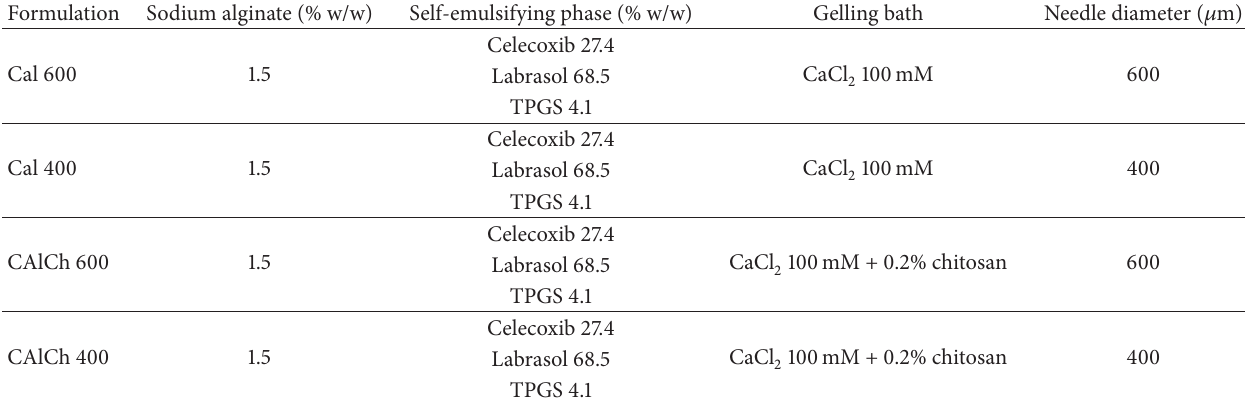
Table 1: Composition of calcium alginate and calcium alginate-chitosan